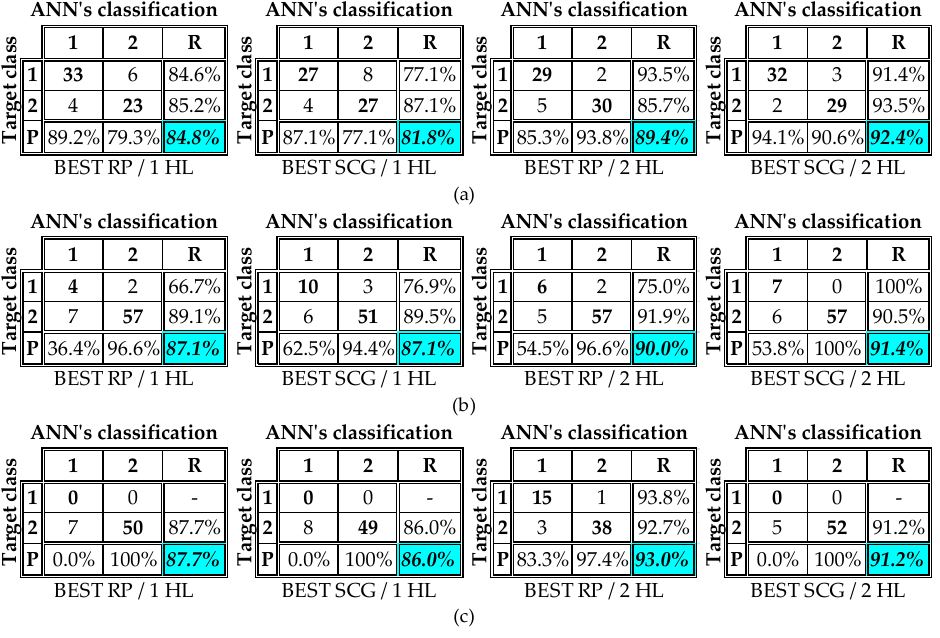
Figure 12. CMs according to the testing subsets extracted by the optimally configured NA2C2M networks: ( a ) BB; ( b ) RIB; ( c ) IIB.